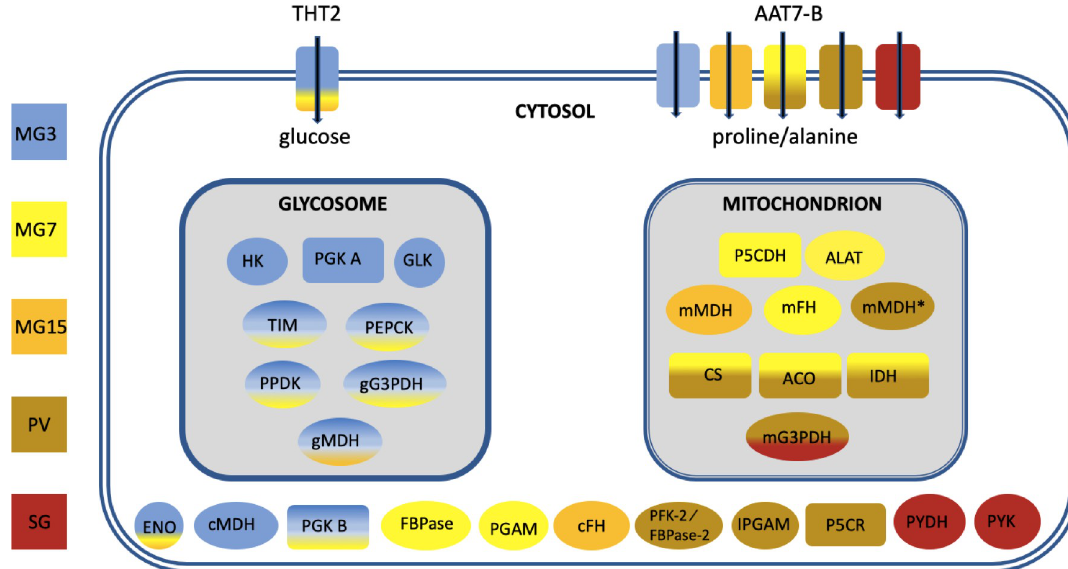
Fig 10. Overview of changes in transcripts encoding metabolic enzymes during fly infection. Gene IDs are provided in Fig 8. Colours reflect the time point or tissue in which expression was maximal. It does not imply that an enzyme is absent in other stages. AAT7-B: amino acid transporters; ACO: aconitase; ALAT: alanine aminotransferase; CS: citrate synthase; ENO: enolase; FBPase: fructose 1,6 biphosphatase; PFK-2/FBPase-2: fructose 2,6 bisphosphatase; cFH: cytosolic fumarate hydratase; mFH: mitochondrial fumarate hydratase GLK: glycerol kinase 1; gG3PDH: glycosomal glycerol-3-phosphase dehydrogenase; mG3PDH: mitochondrial glycerol-3-phosphase dehydrogenase; HK: hexokinase 1; IDH: isocitrate dehydrogenase; IPGAM: cofactor independent phosphoglycerate mutase; cMDH: cytosolic malate dehydrogenase; gMDH: glycosomal malate dehydrogenase; mMDH: mitochondrial malate dehydrogenase; mMDH � : mitochondrial malate dehydrogenase; P5CDH: pyrroline-5-carboxylate dehydrogenase; P5CR: pyrroline-5-carboxylate reductase; PEPCK: phosphoenolpyruvate carboxykinase; PGAM: phosphoglycerate mutase; PGK: phosphoglycerate kinase; PPDK: pyruvate phosphate dikinase; PYDH: pyruvate dehydrogenase; PYK: pyruvate kinase; TIM: triose phosphate isomerase; THT2: high affinity hexose transporters. MG3: midgut day 3; MG7: midgut day 7; MG15: midgut day 15; PV: proventriculus, SG: salivary glands.